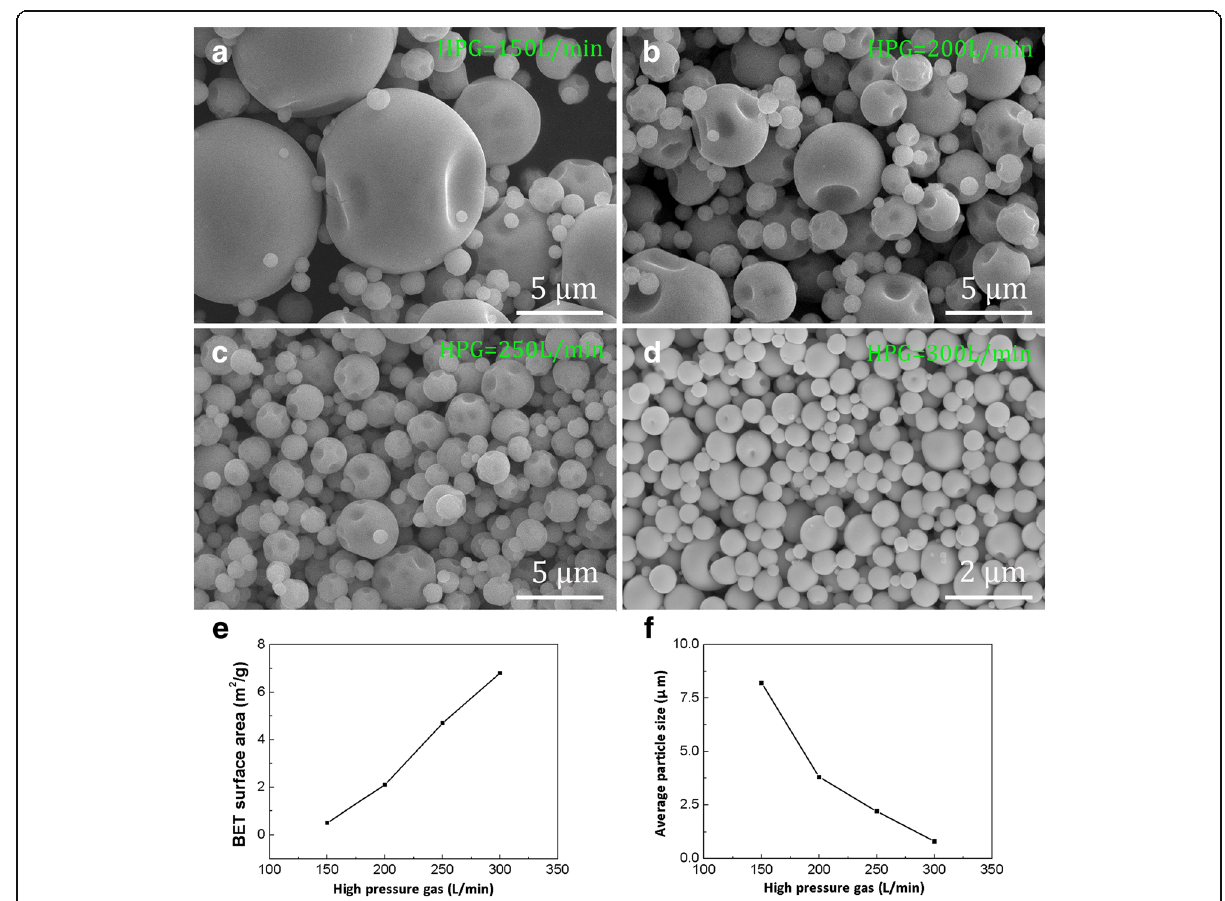
Fig. 4 The microstructure of spray-dried (NH 4 ) 6 W 7 O 24 ·6H 2 O particles in different high-pressure gas. a 150 L/min. b 200 L/min. c 250 L/min. d 300 L/min. e BET surface area. f Average particle